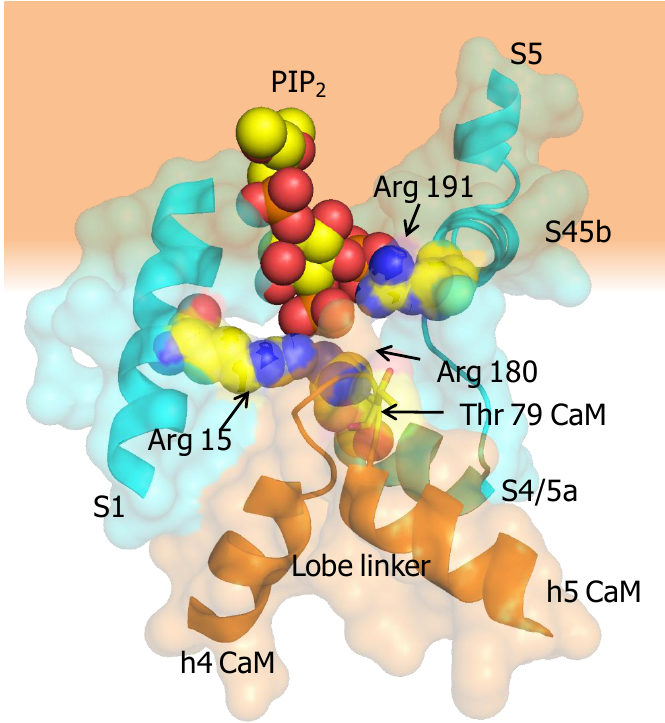
Figure 8. Hypothetical PIP 2 binding site near the CaM Thr 79 phosphorylation site. The pore residues (GYG) were used as a reference to align the Kir structure (PDB 3SYA) to the open configuration of SK4 (PDB 6CNO). The PIP 2 molecule was manually moved maintaining the distance from the membrane to the presumed docking site, and manually adjusted to avoid obvious clashes. The docking space is delimited by S1, S2 and S4 transmembrane segment. The positively charged Arg residues are represented as spheres using the CPK coloring scheme, and CaM Thr 79 is represented as stick.